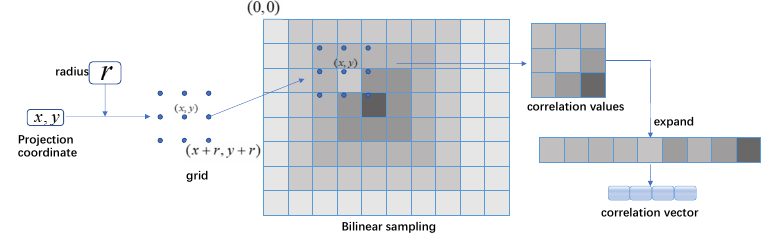
Figure 3. Sampling